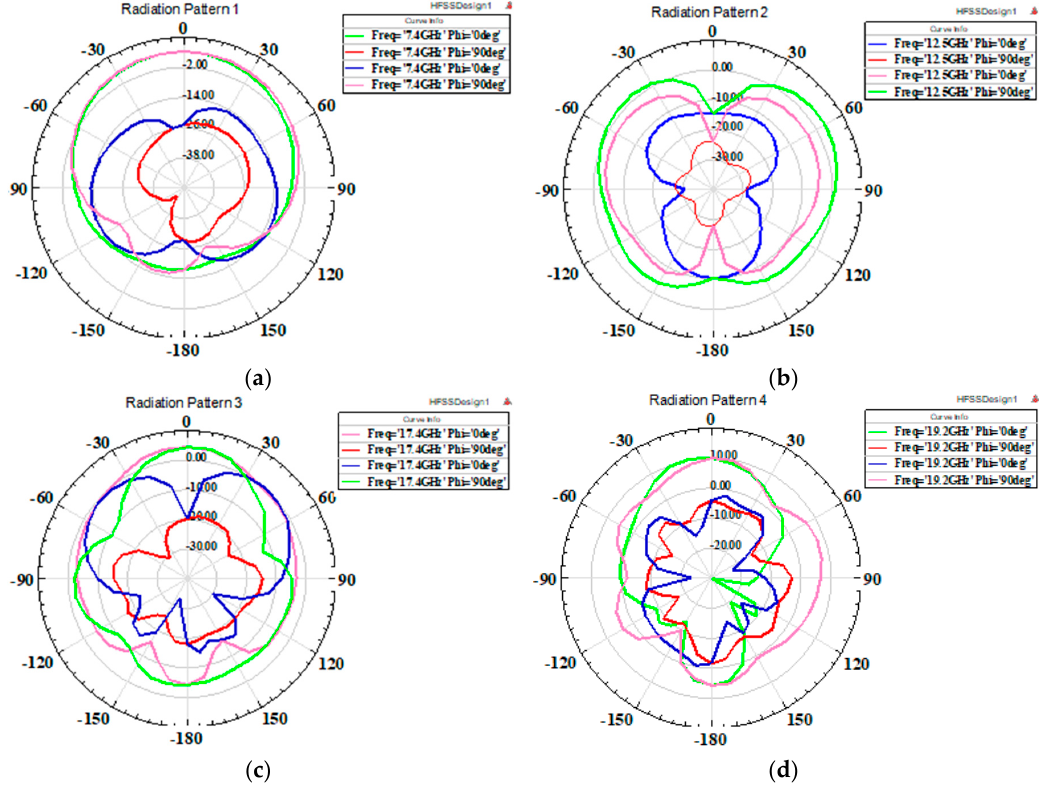
Figure 9. Radiation patterns of the proposed microstrip antenna with slots parallel to resonance edges at ( a ) 7.4GHz ( b ) 12.5GHz ( c ) 17.4GHz ( d ) 19.2GHz.